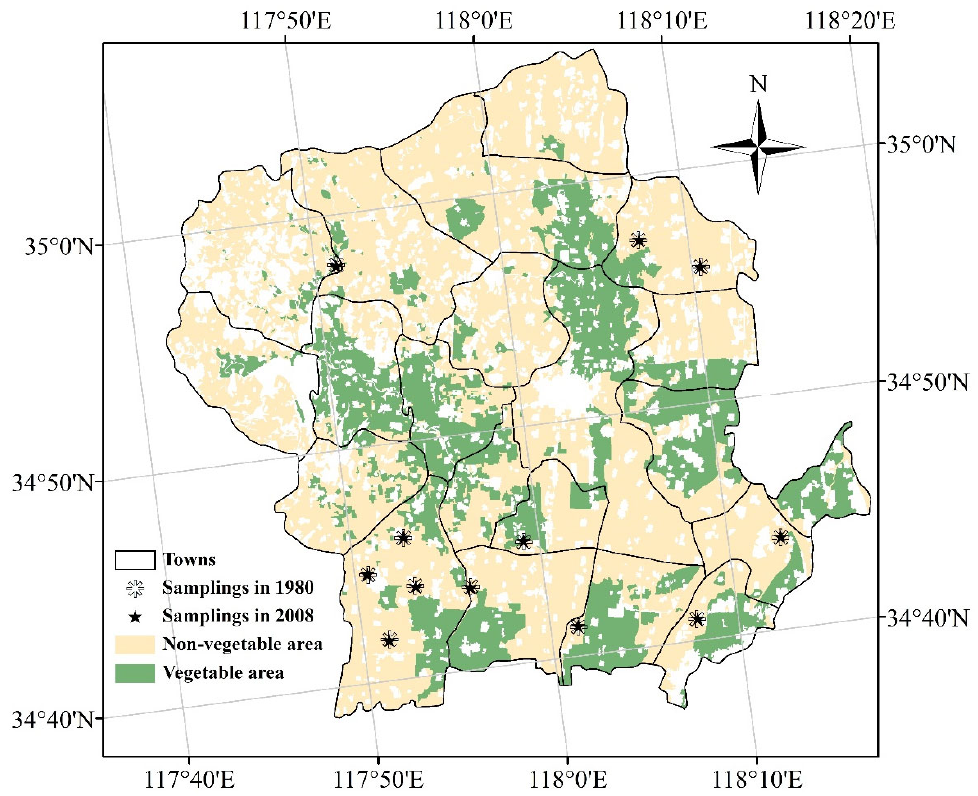
Figure 1. The distribution of non-vegetable and vegetable areas in Cangshan County. Samplings in 1980 and 2008 represent paired measurements of wheat-maize rotation selected from regional soil sampling in 1980 and 2008, respectively (2 sampling sites within 100